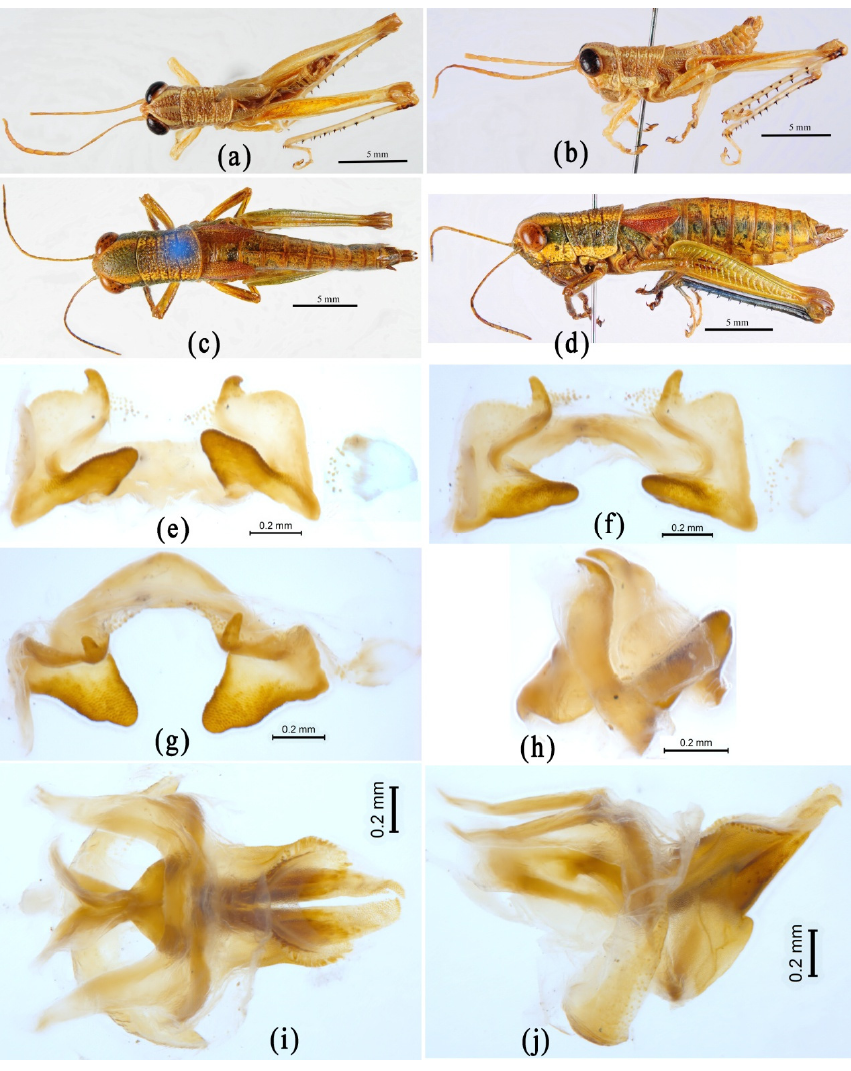
Figure 9. Morphological characters of Longzhouacris mirabilis . ( a , b ) Male habitus. ( c , d ) Female habi- tus. ( e – h ) Epiphallus in dorsal, dorsofrontal, frontal and dorsolateral views. ( i , j ) Phallic complex in dorsal and lateral views.